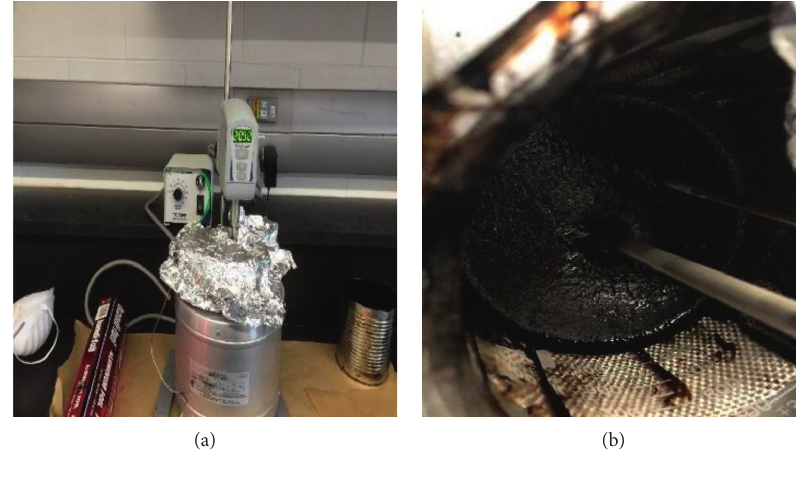
Figure 2: Mechanical shear mixer.